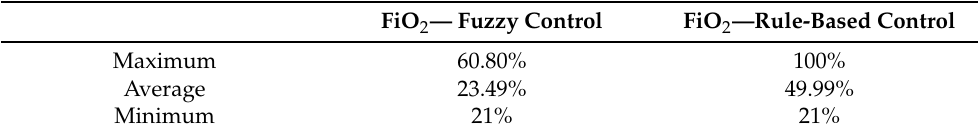
Table 1. Average results for Fuzzy and Rule-based controllers studied in